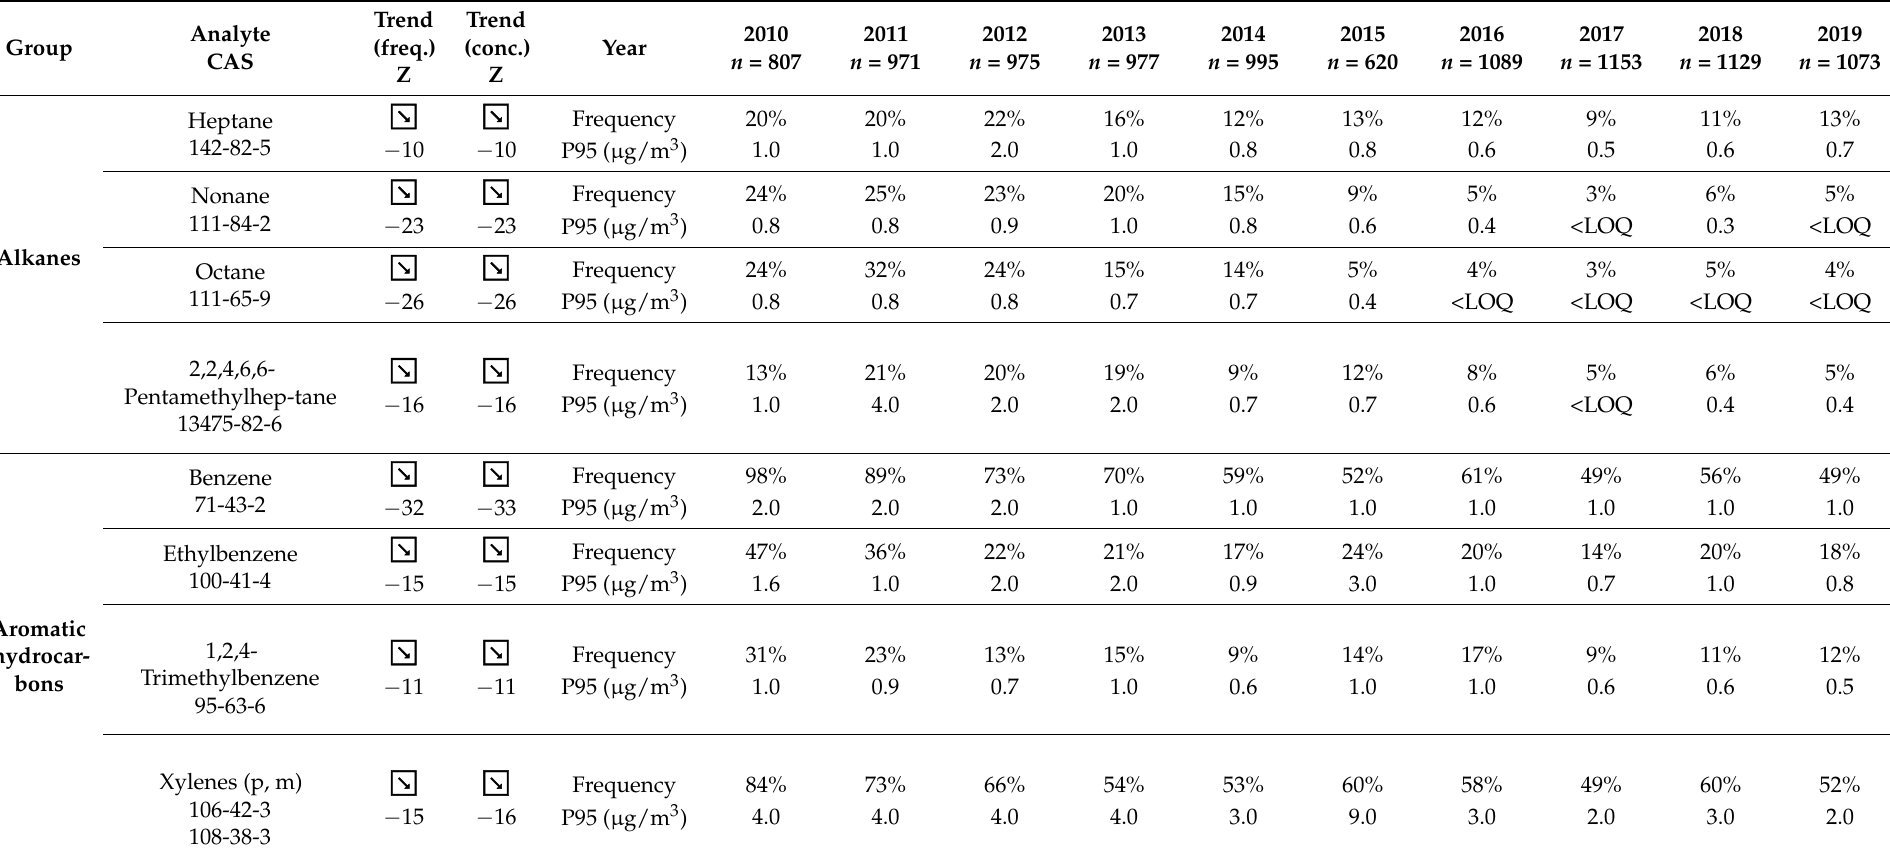
Table 4. Annual statistics of VOCs (a) and formaldehyde (b) during the ten-year study period 2010–2019. Frequency trend was tested using Somer’s D test, where input data were binomial (measurement result either >LOQ or <LOQ). Concentration trend was tested using Somer’s D test, where input data comprised all measured concentration values. Here, measurement results that were <LOQ were replaced by a concentration value LOQ/2. Trends indicated by downward or upward arrow symbol were statistically significant ( p < 0.0001) and had ǀ Z ǀ ≥ 4. Z values shown below arrow symbols indicate direction and steepness of trend. (a) Annual frequency and P95 values of the 42 most common VOCs during the ten-year study period 2010–2019. For TVOC presented on the bottom line, median, and P90 values are also shown.